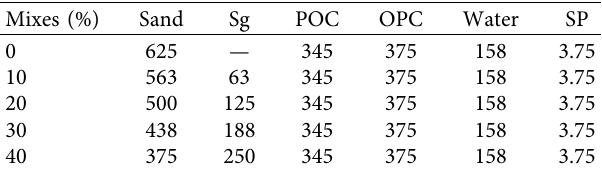
Table 4: Mix proportion used (kg/m 3